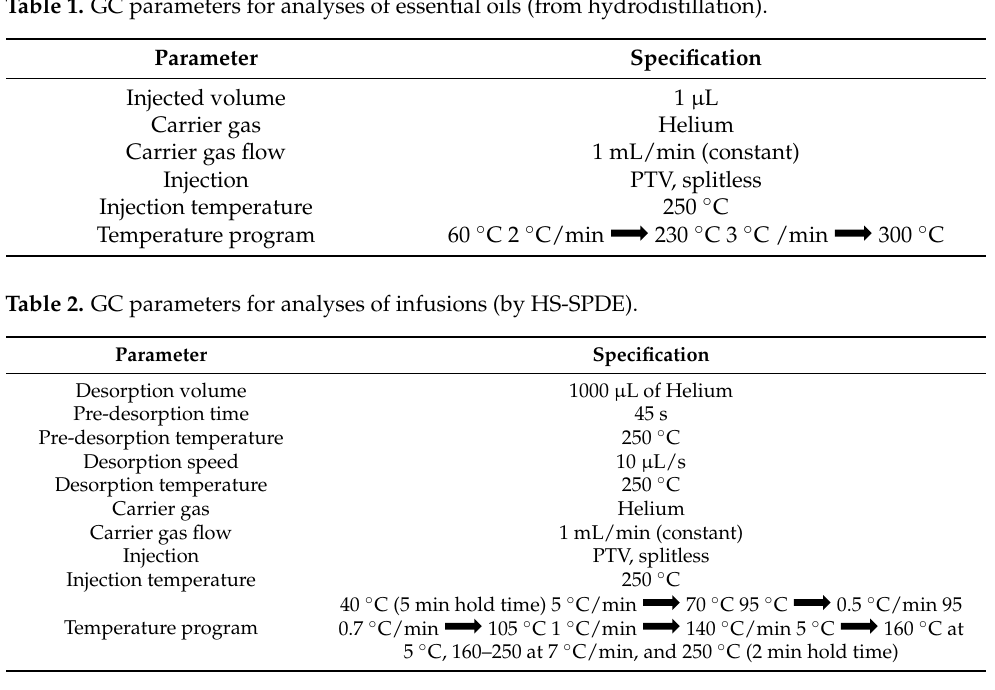
Table 1. GC parameters for analyses of essential oils ( from hydrodistillation ).